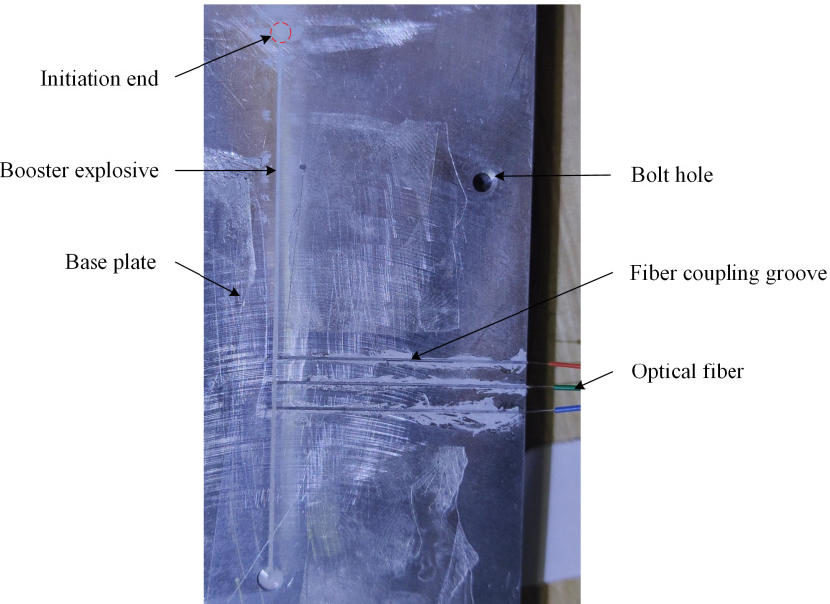
Figure 7. The installation site.